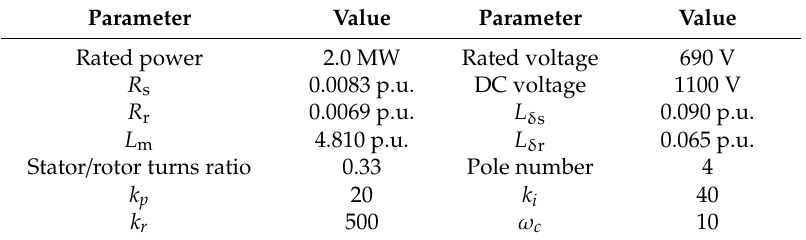
Figure 3. Schematic diagram of the simulated system. Table 1. Parameters of the simulated DFIG.